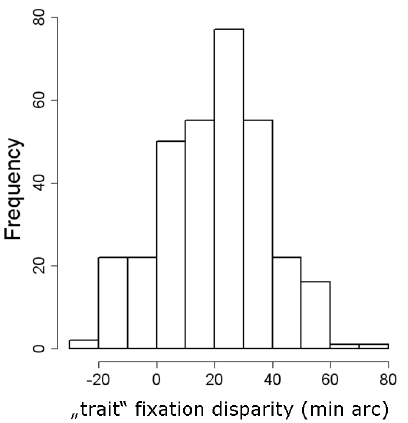
Figure 3: Histogram for the average fixation disparity calculated for each sentence (min arc).